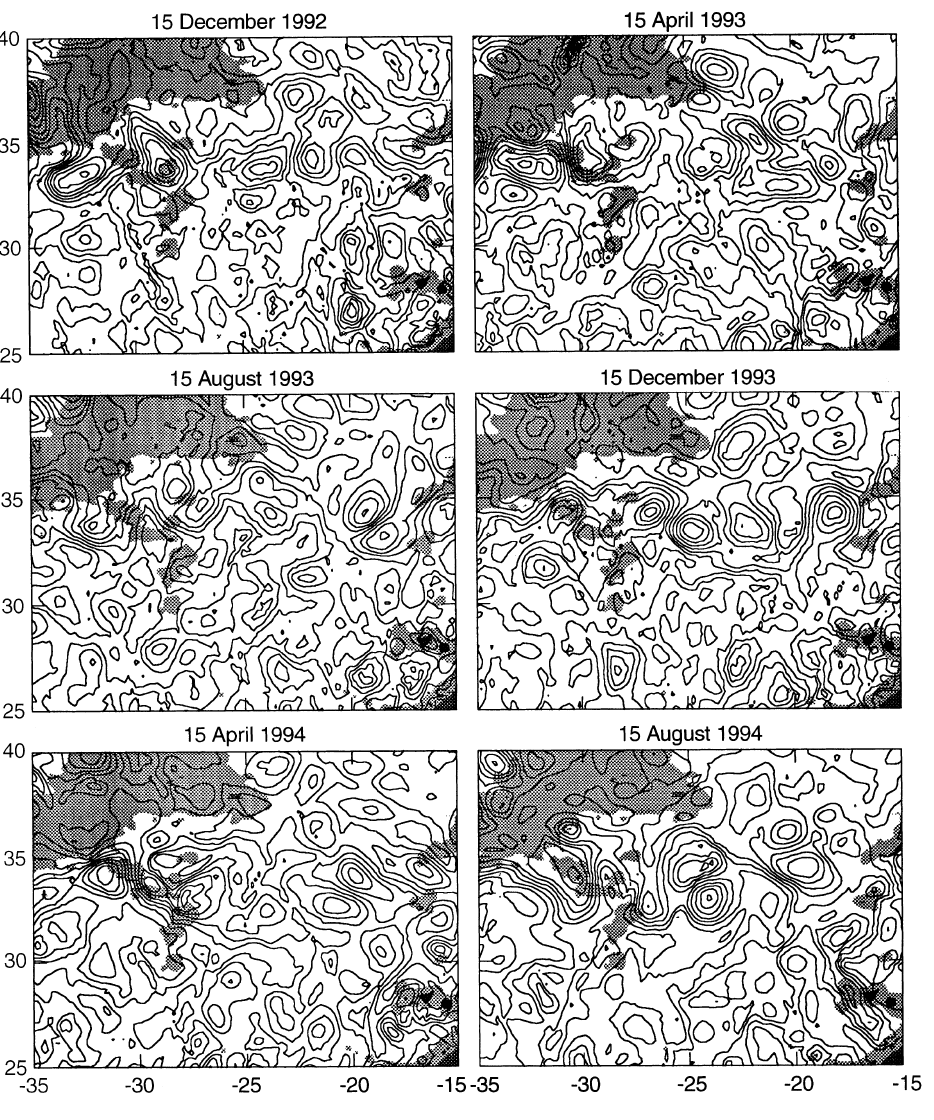
Fig. 2. Instantaneous dynamic topography in the Azores re- gion as predicted by the model on December 15, 1992, April 15, 1993, August 15, 1993, December 15, 1993, April 15, 1994 and August 15, 1994. contour interval (CI): 3 cm. Shading corresponds to the re- gions where the depth is less than